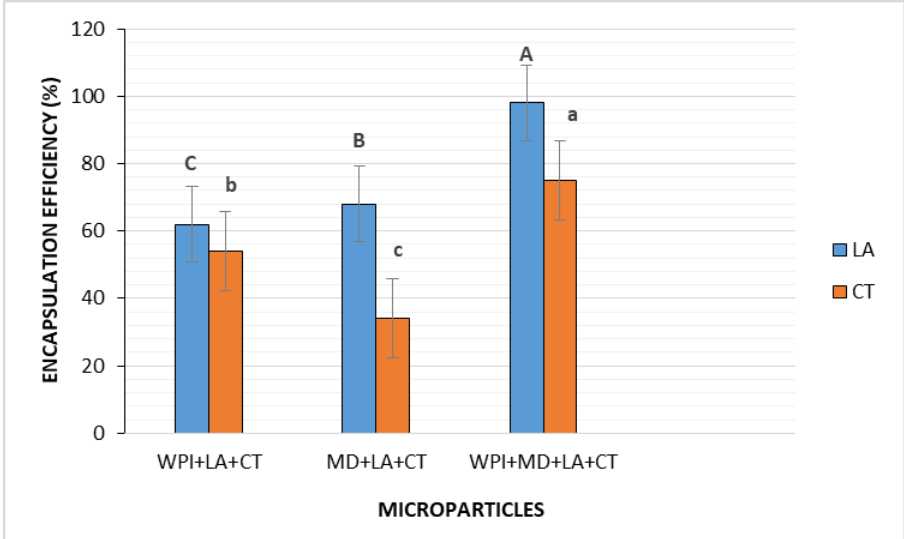
Figure 1. Encapsulation efficiency of microparticles. WPI + LA + CT, MD + LA + CT, and WPI + MD + LA + CT. WPI + LA + CT: Whey protein isolate + L. acidophilus + Charantin ; MD + LA + CT: Maltodextrin + L. acidophilus + Charantin; WPI + MD + LA + CT: Whey protein isolate + Maltodextrin + L. acidophilus + Charantin. Different letters above each column represent significant differences in means ( p < 0.5).